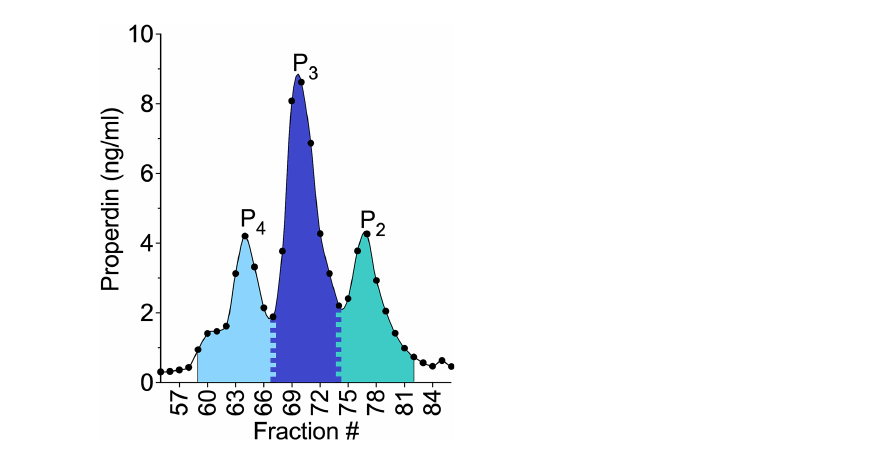
FIGURE 1 Visual representation of the method for determining the ratio of properdin oligomers using the properdin sandwich ELISA data from the fractions collected after performing size exclusion chromatography on NHS, from donor #4 as described in “ Materials and Methods ” (section 2.7);. The width of the P 4 peak was considered fi ve fractions to the left of the P 4 top fraction and all fractions to the right of the top fraction up until the fraction present in the valley between the P 4 and P 3 . The fraction present at the valley between peaks was assigned to both P 4 and P 3 by dividing the concentration of that fraction equally between the two properdin oligomers. The width of the dimer peak was considered fi ve fractions to the right of the P 2 top fraction and all fractions to the left up until the valley between the P 2 and P 3 peaks. The fraction present at the valley between these peaks was assigned to both P 2 and P 3 by dividing the concentration of that fraction equally between the two properdin oligomers. The width of the P 3 peak was de fi ned as all fractions in between the P 4 /P 3 valley and the P 3 /P 2 valley. After assigning fractions to properdin oligomers, the concentration from fractions belonging to each properdin oligomer form was totaled. Then, all fractions, from all oligomers were summed for a grand total. The ratio of properdin oligomers was determined by dividing the total concentration of each properdin oligomer by the grand total and multiplying by